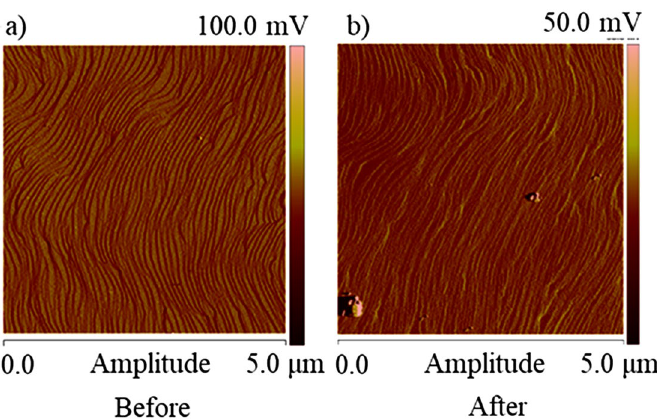
Figure 3. AFM images of the GaN:Si surface ( a ) before and ( b ) after He-ion implanatation. 20 nm SiN cap layer, was removed before AFM scans were